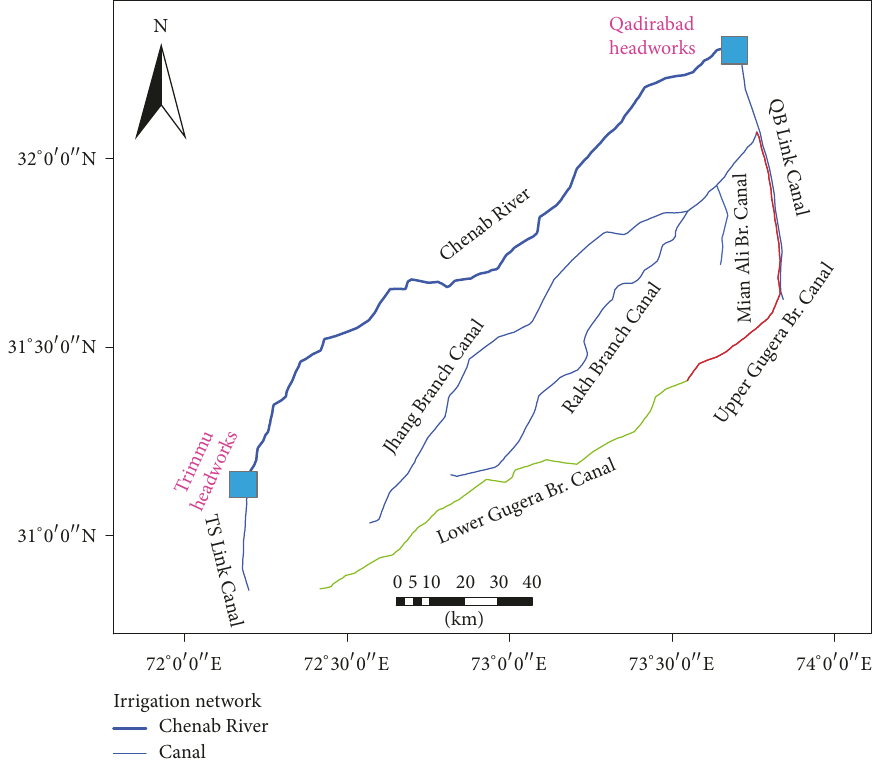
Figure 2: Canal network of the study